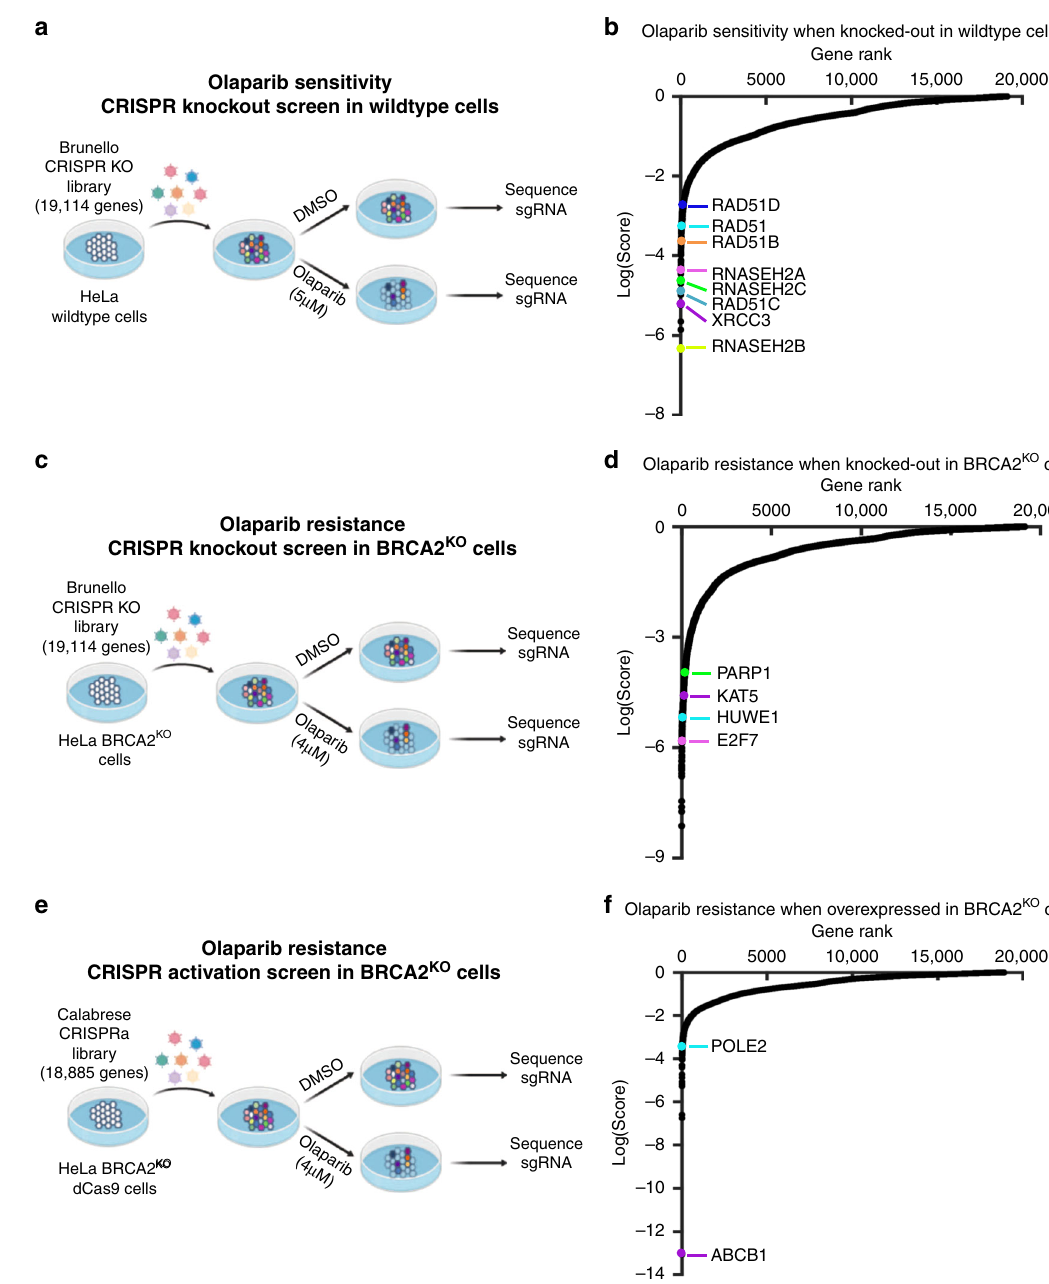
Fig. 1 Complementary CRISPR knockout and activation screens identify determinants of PARPi response in parental or BRCA2-knockout HeLa cells. a Schematic representation of the CRISPR knockout screen for olaparib sensitivity in wildtype cells. HeLa cells were infected with the Brunello CRISPR knockout library. Infected cells were divided into PARP inhibitor (olaparib)-treated or control (DMSO) arms. Genomic DNA was extracted from cells surviving the drug treatment and single-guide RNAs (sgRNAs) were identi fi ed using Illumina sequencing. b Scatterplot showing the results of this screen. Each gene targeted by the library was ranked based on the MAGeCK negative selection score. Several biologically interesting hits are highlighted. c Schematic representation of the CRISPR knockout screen for olaparib resistance in BRCA2 KO cells. HeLa BRCA2 KO cells were infected with the Brunello CRISPR knockout library. Infected cells were divided into PARP inhibitor (olaparib)-treated or control (DMSO) arms. d Scatterplot showing the results of this screen, with several biologically interesting hits highlighted. Each gene targeted by the library was ranked based on the MAGeCK positive selection score. e Schematic representation of the CRISPR activation screen for olaparib resistance in BRCA2 KO cells. HeLa BRCA2 KO cells stably expressing the modi fi ed dCas9 enzyme were infected with the Calabrese CRISPR activation library. Infected cells were divided into PARP inhibitor (olaparib)-treated or control (DMSO) arms. f Scatterplot showing the results of this screen, with several biologically interesting hits highlighted. Each gene targeted by the library was ranked based on the MAGeCK positive selection score. Source data are provided as a Source Data fi